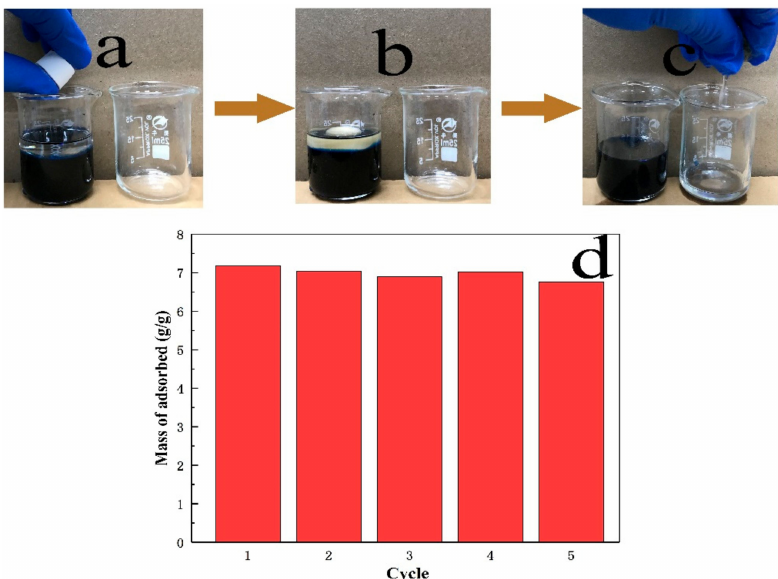
Figure 7. ( a – c ) Absorbed xylene (the upper clear liquid) and then squeezed out by hand to separate xylene from water (colored with indigo carmine for clear presentation); ( d ) Squeezing was used to recycle monoliths for sorption of